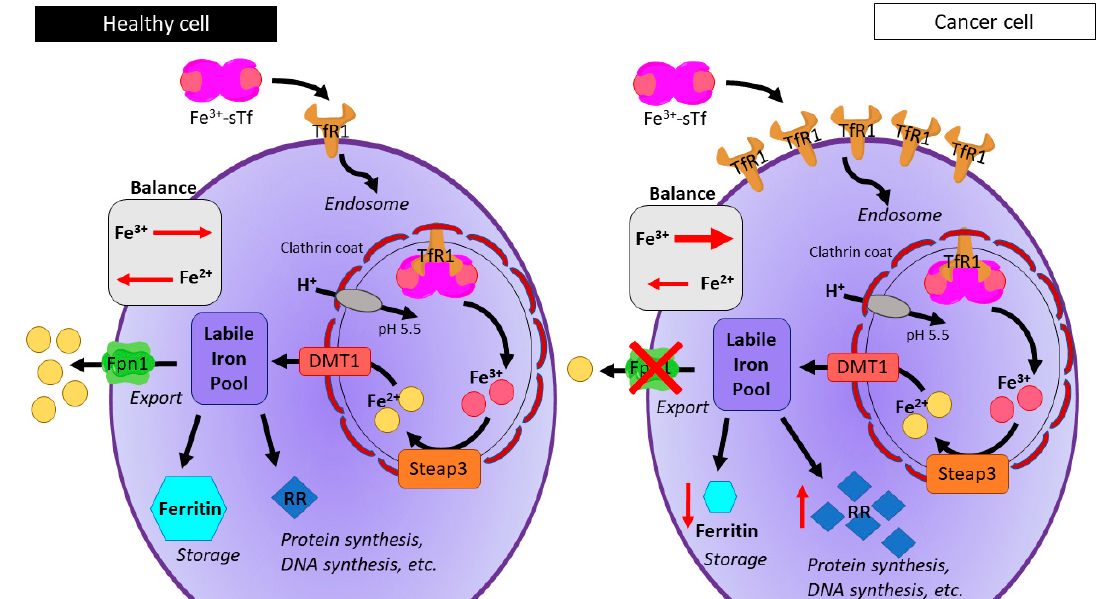
Figure 7. The endocytotic uptake of Fe(III) bound by sTf and trafficking and storage of Fe within the cell. In all cells, Fe(III)-bound sTf interacts with the TfR1, which then promotes the transport of Fe(III) across the cell membrane by endocytosis. A combination of pH decrease and Fe(III) reduction by STEAP3 within the endosome results in the release of Fe from sTf and transport as Fe(II) through the divalent metal transporter 1 (DMT1) into the cytosol. Fe(II) is then trafficked to several biomolecules that depend on it for activity such as ribonucleotide reductase (RR). Some of the is stored by ferritin. A portion of the Fe(II) remains part of a labile iron pool (LIP), readily accessible for use within the cell. In healthy cells there is a homeostasis between the amount of Fe that enters the cell through the transferrin receptor-1 (TfR1) and exported via ferroportin-1 (Fpn1). In cancer cells, there is a higher requirement for Fe and therefore these cells have an overexpression of TfR1 relative to healthy cells and a decreased expression of Fpn1. There is also less storage of the metal and an increased use of it. RR is overexpressed, which facilitates cancer proliferation.